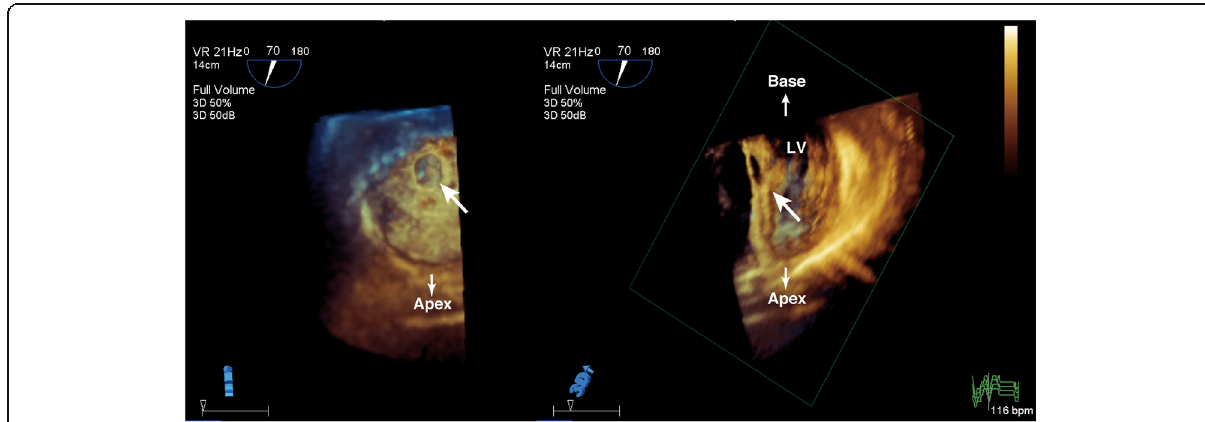
Fig. 3 Three-dimensional images of the orifice of the pseudoaneurysm from outside (left) and inside (right). The images were obtained in the transgastric view. The attachment site of the posteromedial papillary muscle (arrows) is located very close to the orifice. This finding suggests that repair of the left ventricular pseudoaneurysm might influence papillary muscle